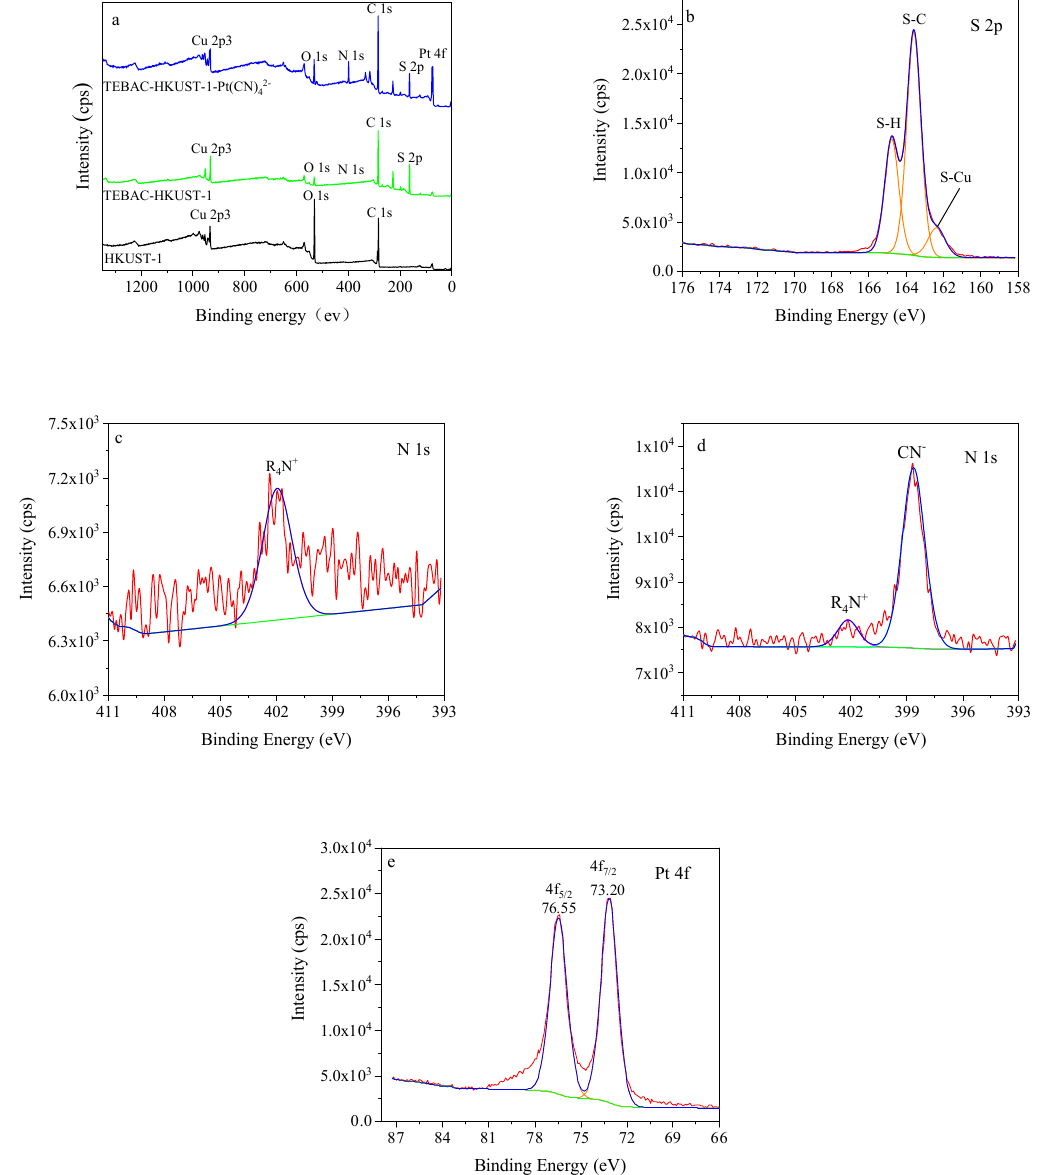
Figure 6. The wide XPS spectra ( a ); S 2p XPS spectrum of TEBAC-HKUST-1 ( b ); nitrogen 1s XPS spectrum of TEBAC-HKUST-1 ( c ); nitrogen 1s XPS spectrum of TEBAC-HKUST-1-Pt(CN) 42 − ( d ); Pt 4f XPS spectrum of TEBAC-HKUST-1-Pt(II) ( e ).